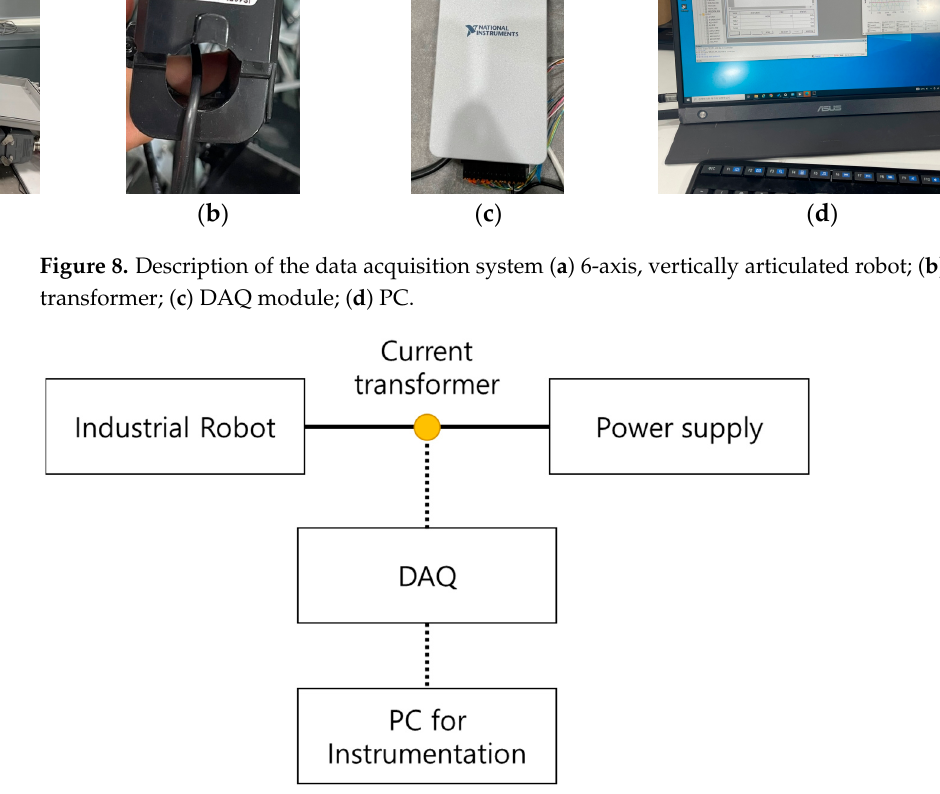
Figure 9. Flow diagram of the DAQ system of the experiment.